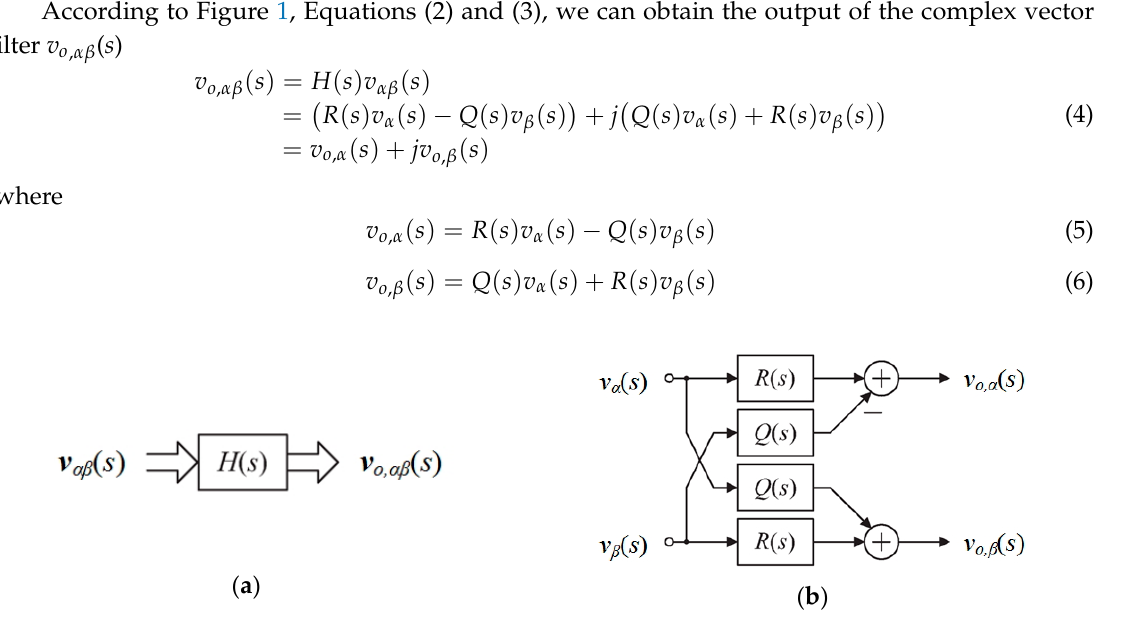
Figure 1. Complex vector filter. ( a ) Description of complex vector filter; ( b ) Implementation diagram of the complex vector filter.